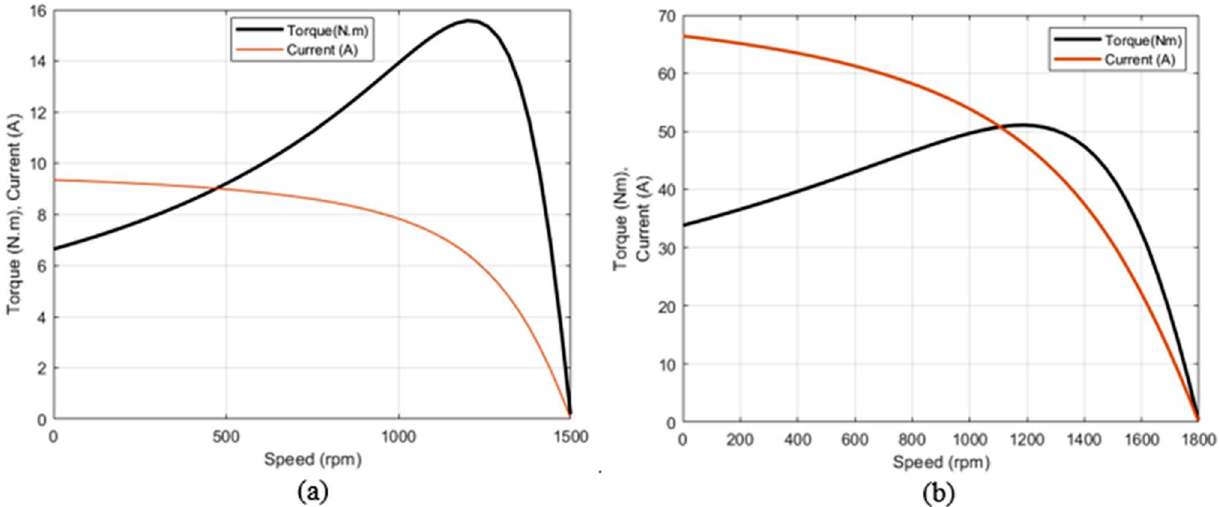
Fig. 8 Torque (Nm), Input current (A) against rotor speed (rpm) for a M1 b